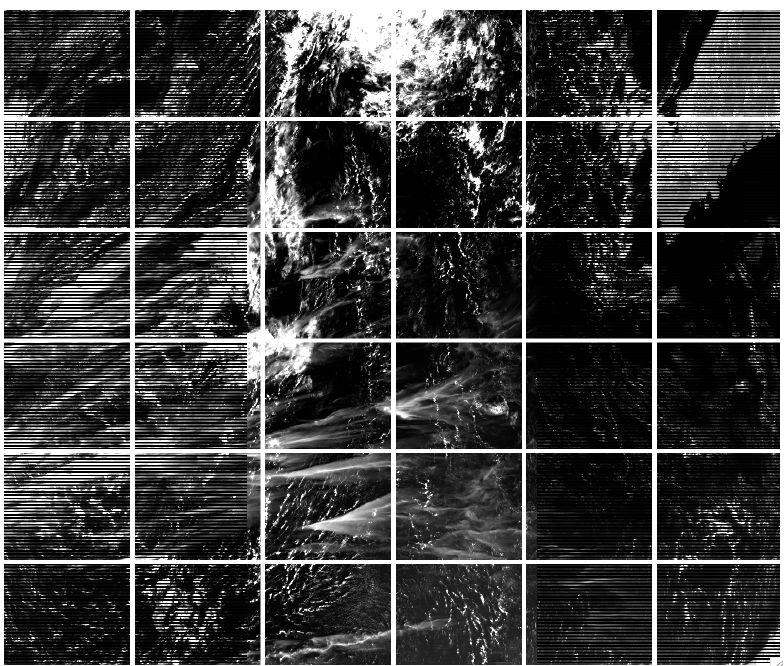
Figure 6. A VIIRS M5 (0.672 μ m) image acquired on 10 July 2017 at UTC 0936. The complete scene is divided into 6 × 6 smaller sub-scenes during the cirrus reflectance retrieving process.